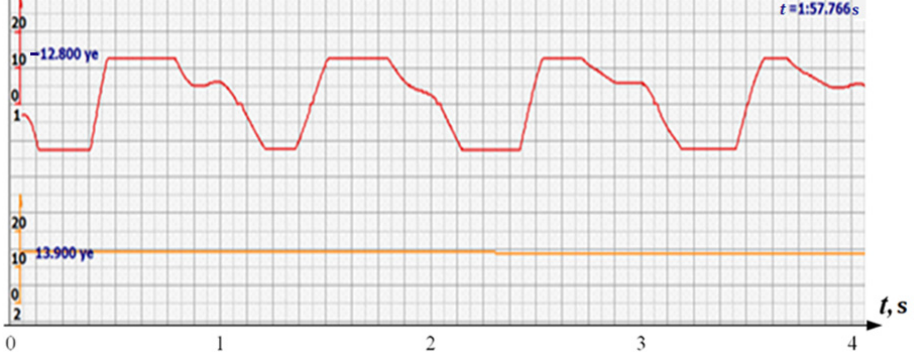
Figure 5. Ultrasonic signal (USS) conversion after filtering and amplification-red diagram. Heart rate determined by the fundamental harmonic of USS—yellow